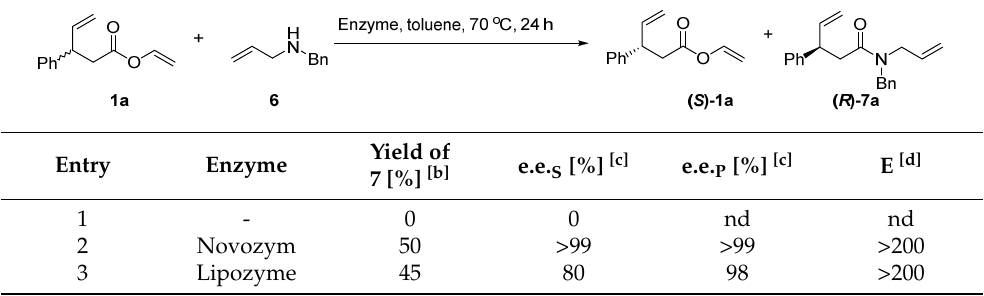
Table 4. The influence of an alkoxy group donor on enzymatic transesterification of ester 1a [a] .